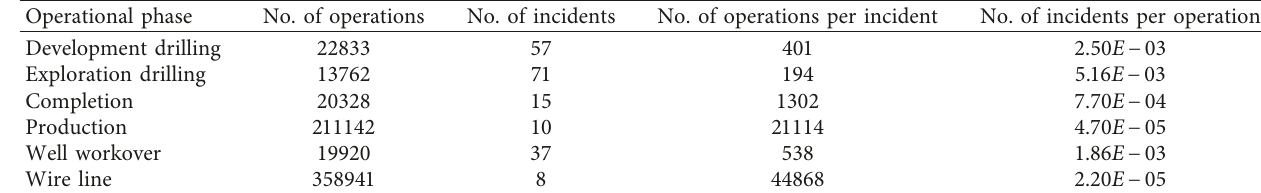
Table 1: The blowout frequencies during the different operational phases (data based on the experience from US GoM OCS, UK, and Norway in the period